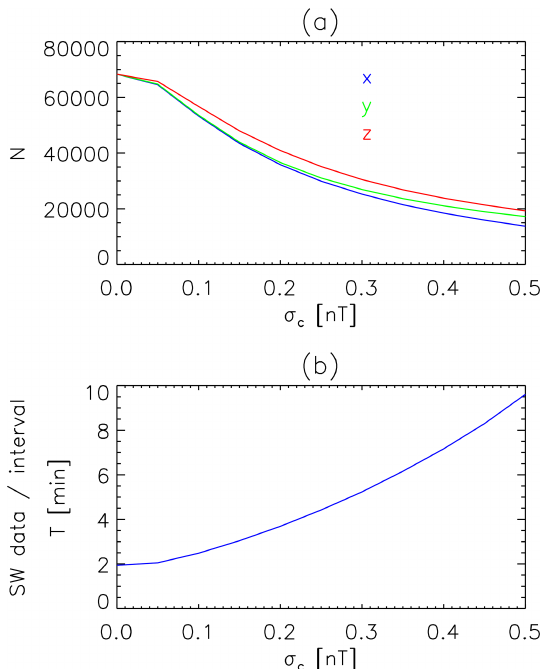
Figure 2. (a) Numbers N of 1min intervals selected when using the threshold σ c on component standard deviations σ in the magnetic field; N pertaining to x , y , and z components shown in blue, green, and red, respectively. (b) Minutes of solar wind data T required to obtain one selected interval as a function of σ c , derived from x component N(σ c )